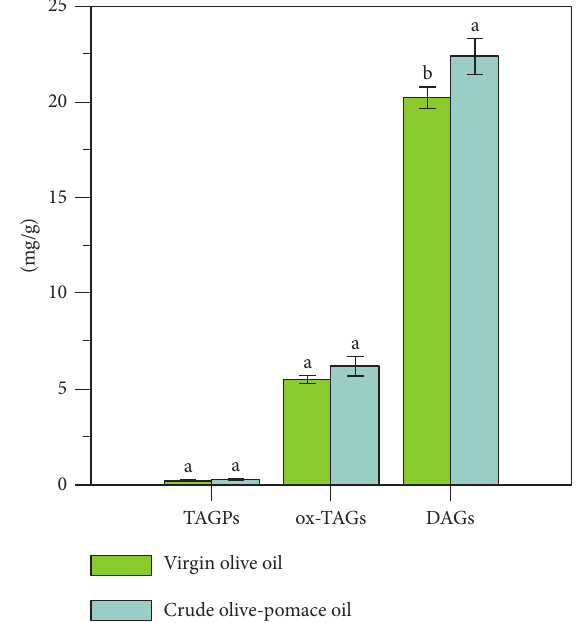
Figure 2: Results of the HPSEC analysis of polar compounds of the crude olive-pomace oil and the corresponding virgin olive oils obtained from the same olive lot (mean and standard deviations; 𝑛 = 4 ; i.e., 2 replicated oil production trials and 2 independent HPSEC analyses each). TAGPs = triacylglycerol oligopolymers; ox- TAGs = oxidized triacylglycerols; DAGs = diacylglycerols. Different letters for the same parameter indicate significant differences at 𝑝 < 0.05.